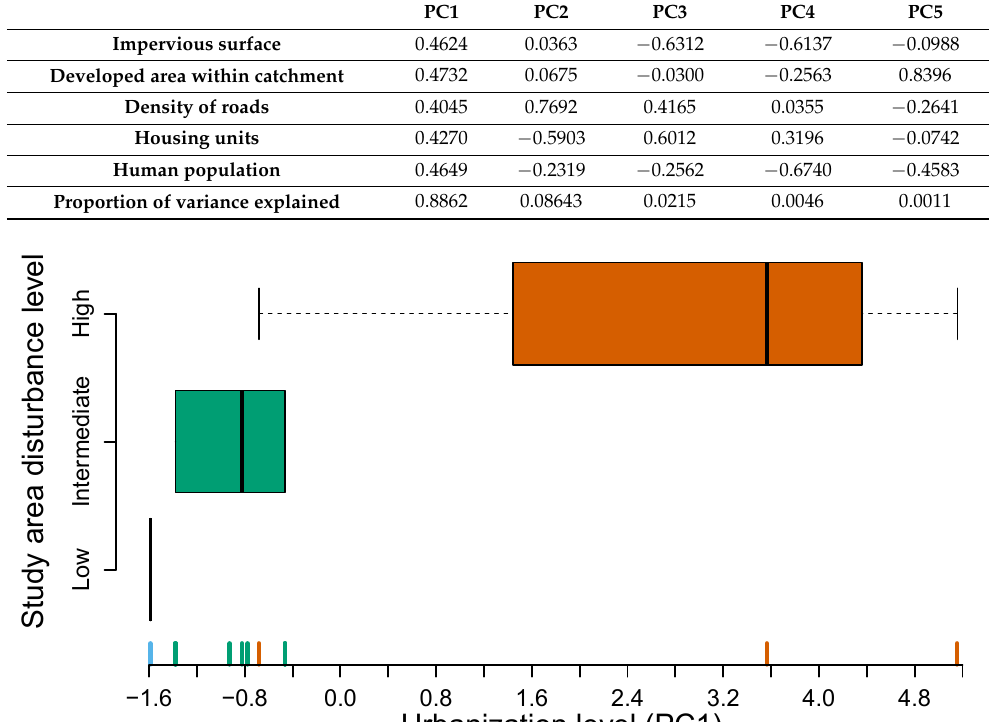
Table 2. Loadings and proportion of variance explained on different principal component (PC) axes from a principal components analysis.